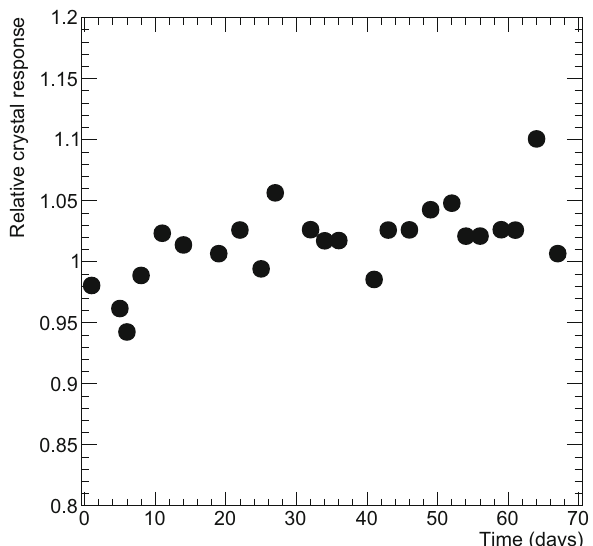
Fig. 17 Longtermstabilityofasinglecrystaloveraperiodof2months